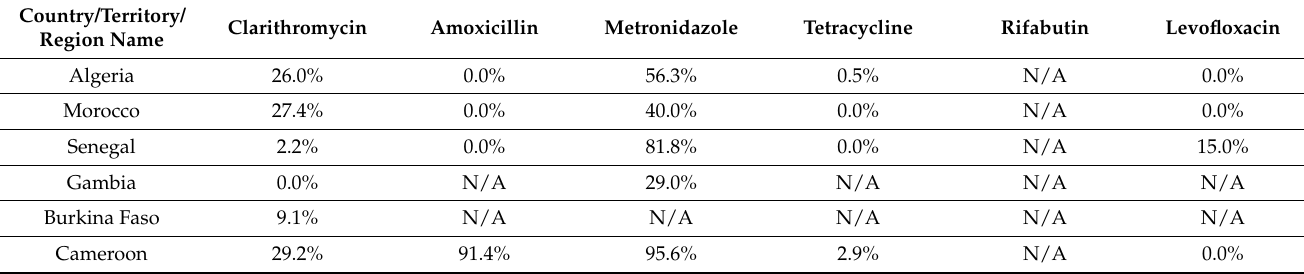
Table 6. Africa Regional Rates of